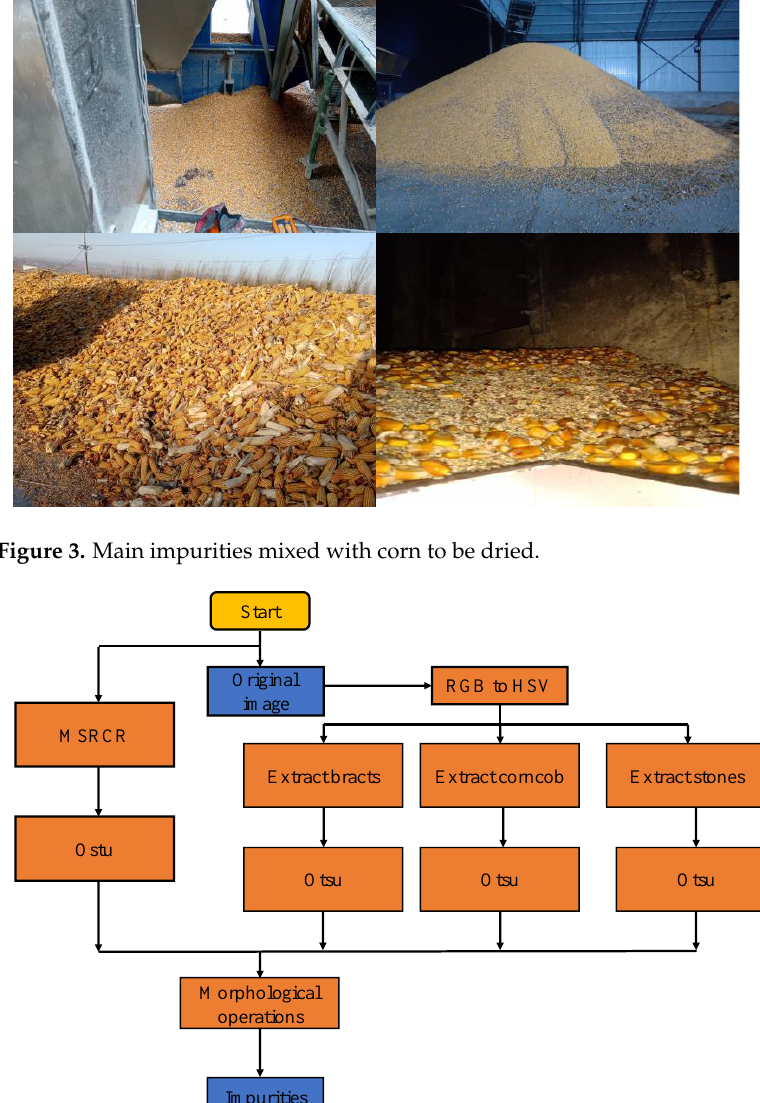
Figure 3. Main impurities mixed with corn to be dried.